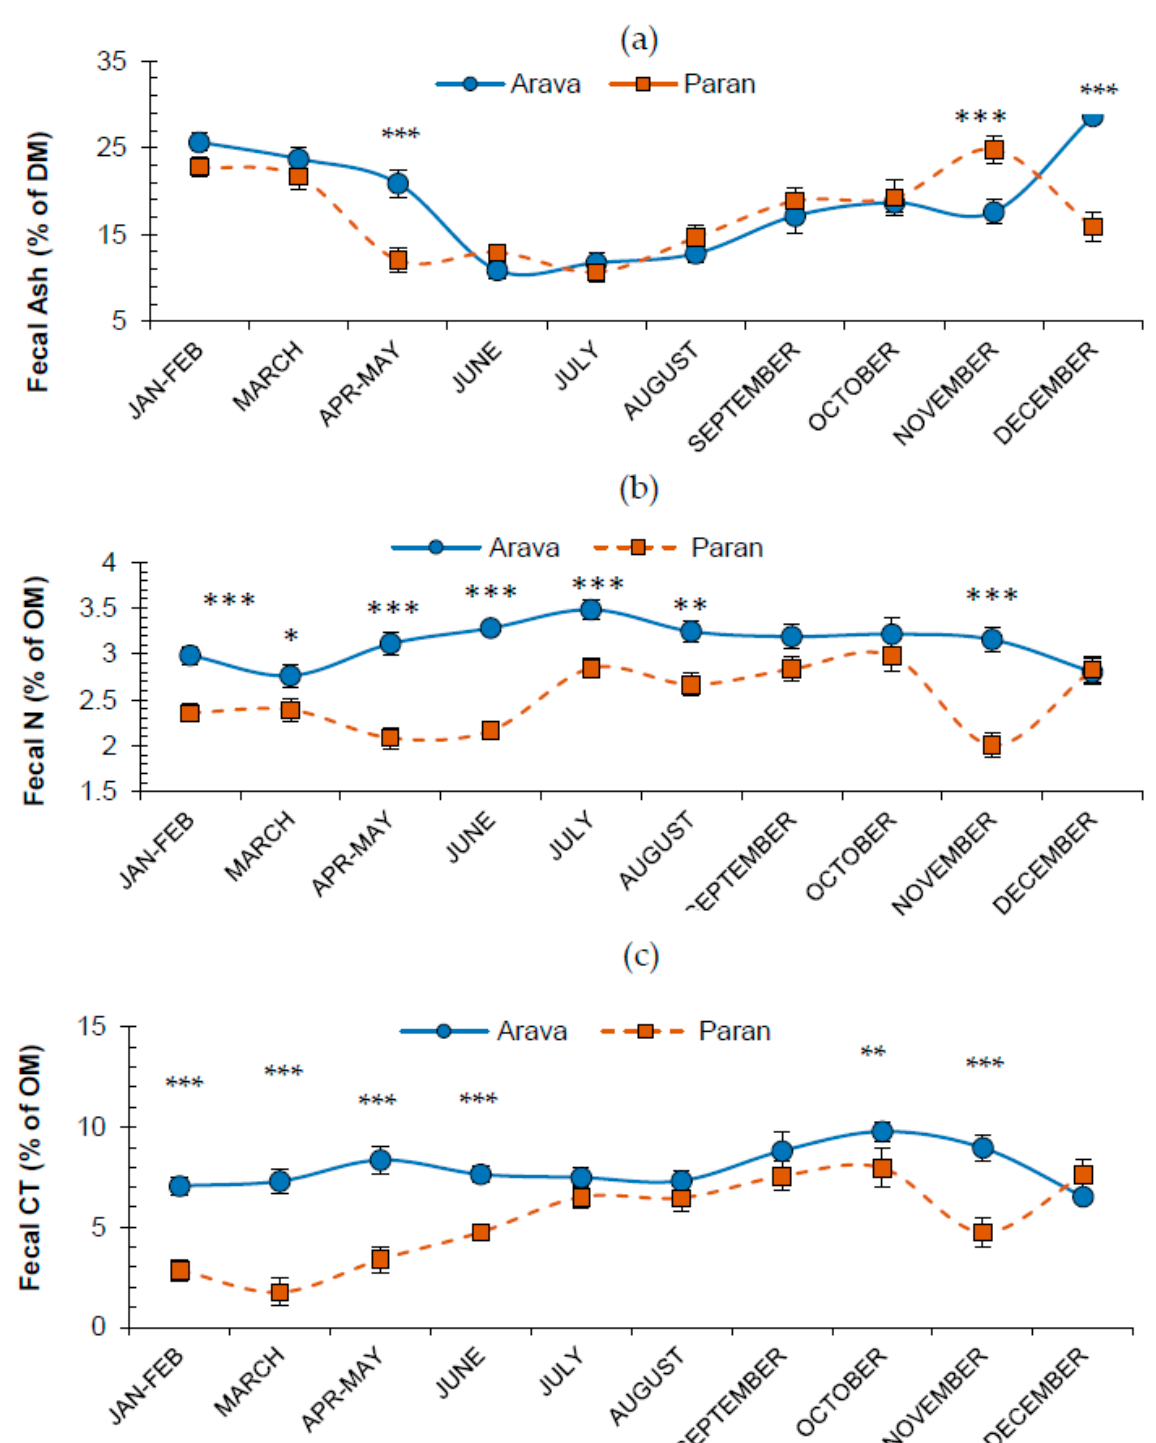
Figure 4. Fecal concentrations of ( a ) ash (% of dry matter); ( b ) N (% of organic matter); and ( c ) condensed tannins (% of organic matter) in Oryx released at the Arava and Paran sites: monthly averages and SE. *** p < 0.001; ** p < 0.01; * p < 0.05.